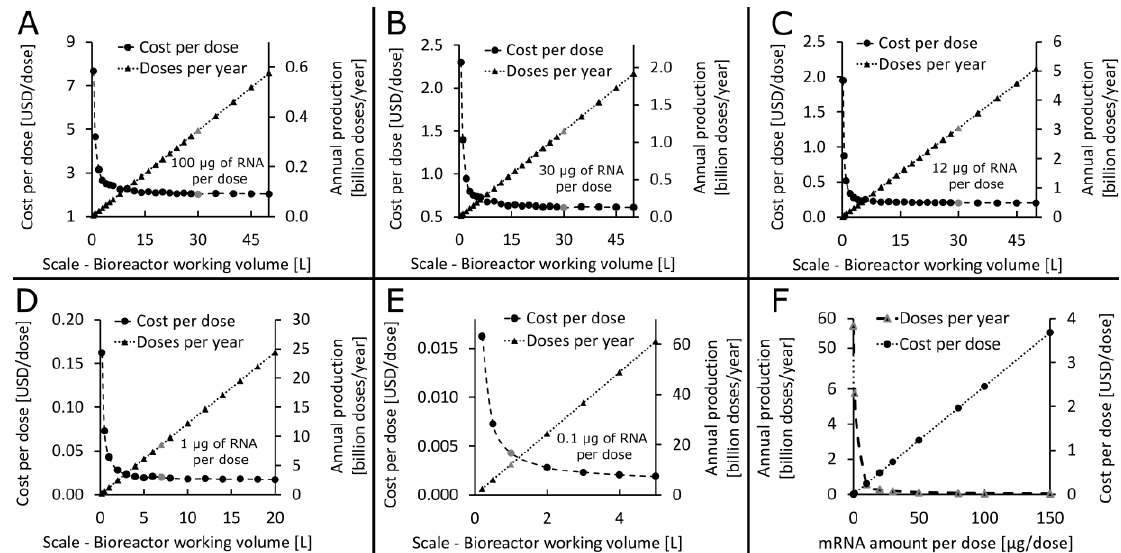
Figure 2. Determining the techno-economically feasible production scale for five vaccines with varying RNA amount per dose listed in Table 1. The entire process is scaled up proportionally and the scale is indicated by the bioreactor working volume. ( A ) Identifying the techno-economically feasible production scale for a 100 µg/dose RNA vaccine with modified UTPs. The annual production amounts and the drug substance production cost per dose is plotted in function of the scale of the production process. The scale identified as technologically feasible and economically viable corresponds to the 30 L bioreactor working volume and the corresponding key performance indicators (KPIs) of annual production and cost per dose values are shown by the grey dot and triangles, respectively. ( B ) Determining the suitable production scale for a 30 µg/dose RNA vaccine with modified UTPs. Plotting the annual production amounts and cost per dose in function of production scale identified the techno-economically feasible scale at 30 L bioreactor working volume, corresponding KPIs are indicated by the grey dot and triangle. ( C ) Determining the suitable production scale for a 12 µg/dose RNA vaccine with wild-type UTPs. Plotting the annual production amounts and cost per dose in function of production scale identified the techno-economically feasible scale at 30 L bioreactor working volume, corresponding KPIs are indicated by the grey dot and triangle. ( D ) Determining the suitable production scale for a 1 µg/dose RNA vaccine with wild-type UTPs. Plotting the annual production amounts and cost per dose in function of production scale identified the techno-economically feasible scale at 7 L bioreactor working volume, corresponding KPIs are indicated by the grey dot and triangle. ( E ) Determining the suitable production scale for a 0.1 µg/dose RNA vaccine with wild-type UTPs. Plotting the annual production